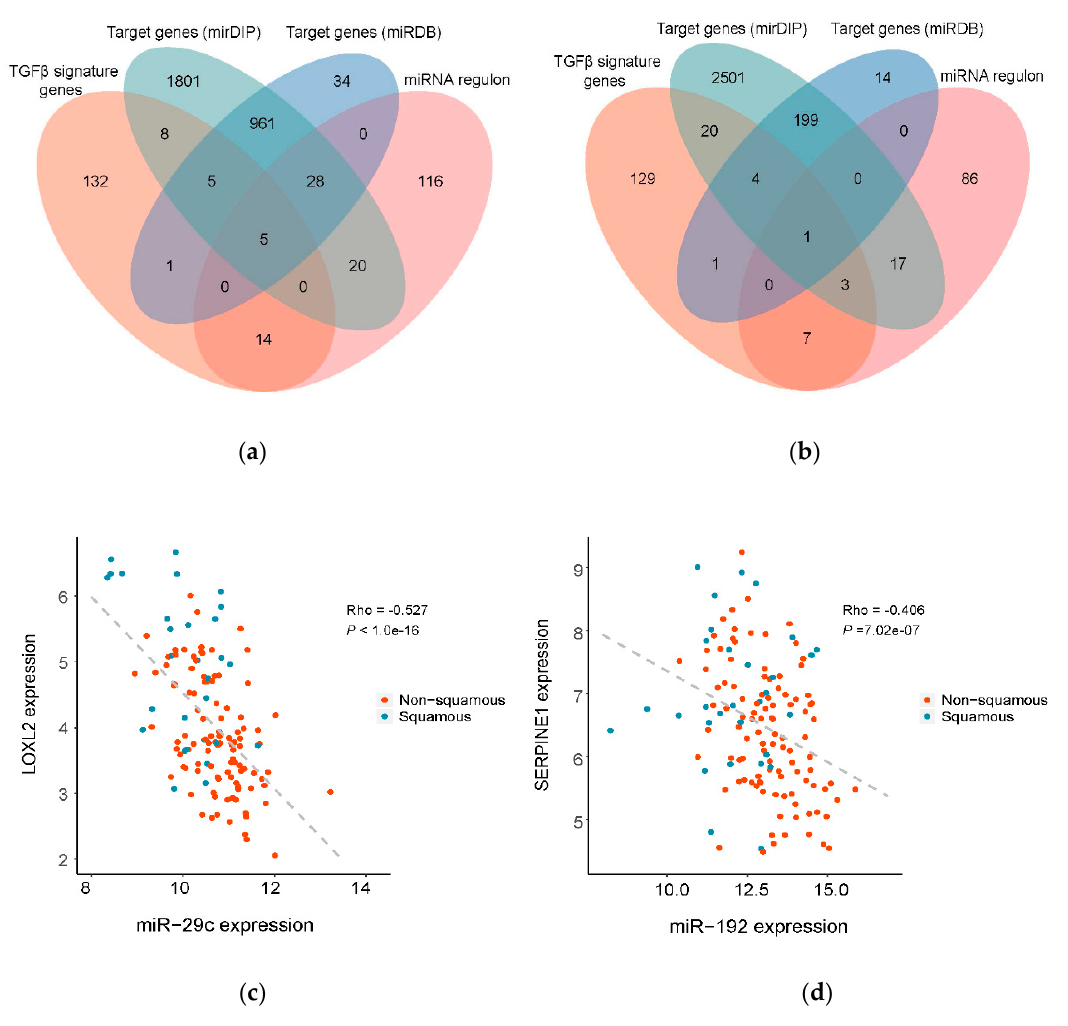
Figure 5. Identification of downstream target genes of miR-29c and miR-192 mediating TGF β signaling pathway. ( a , b ) Venn diagram illustrating target gene prediction for miR-29c and miR-192 respectively by taking the intersection between predicted physical target genes by miRDB and mirDIP databases, TGF β signature genes and predicted functional target genes in the regulon of miRNAs in the regulatory network. ( c , d ) Significant inverse correlation between two candidate target genes, LOXL2 and SERPINE1, and corresponding master regulatory miRNAs. The expression profiles were from the TCGA dataset. Rho: Spearman correlation coefficient.